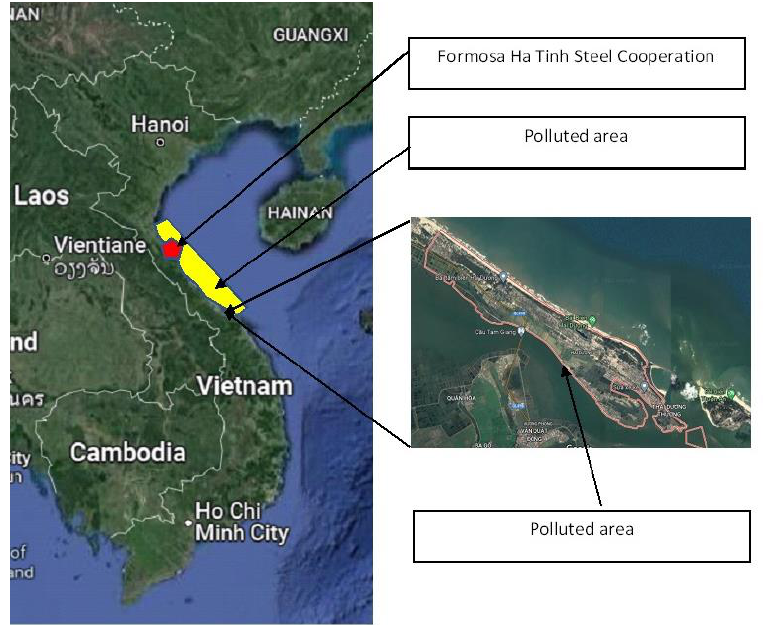
Fig. 1. Polluted region of the FHS incident and the location of Hải Dương commune (modified from Google